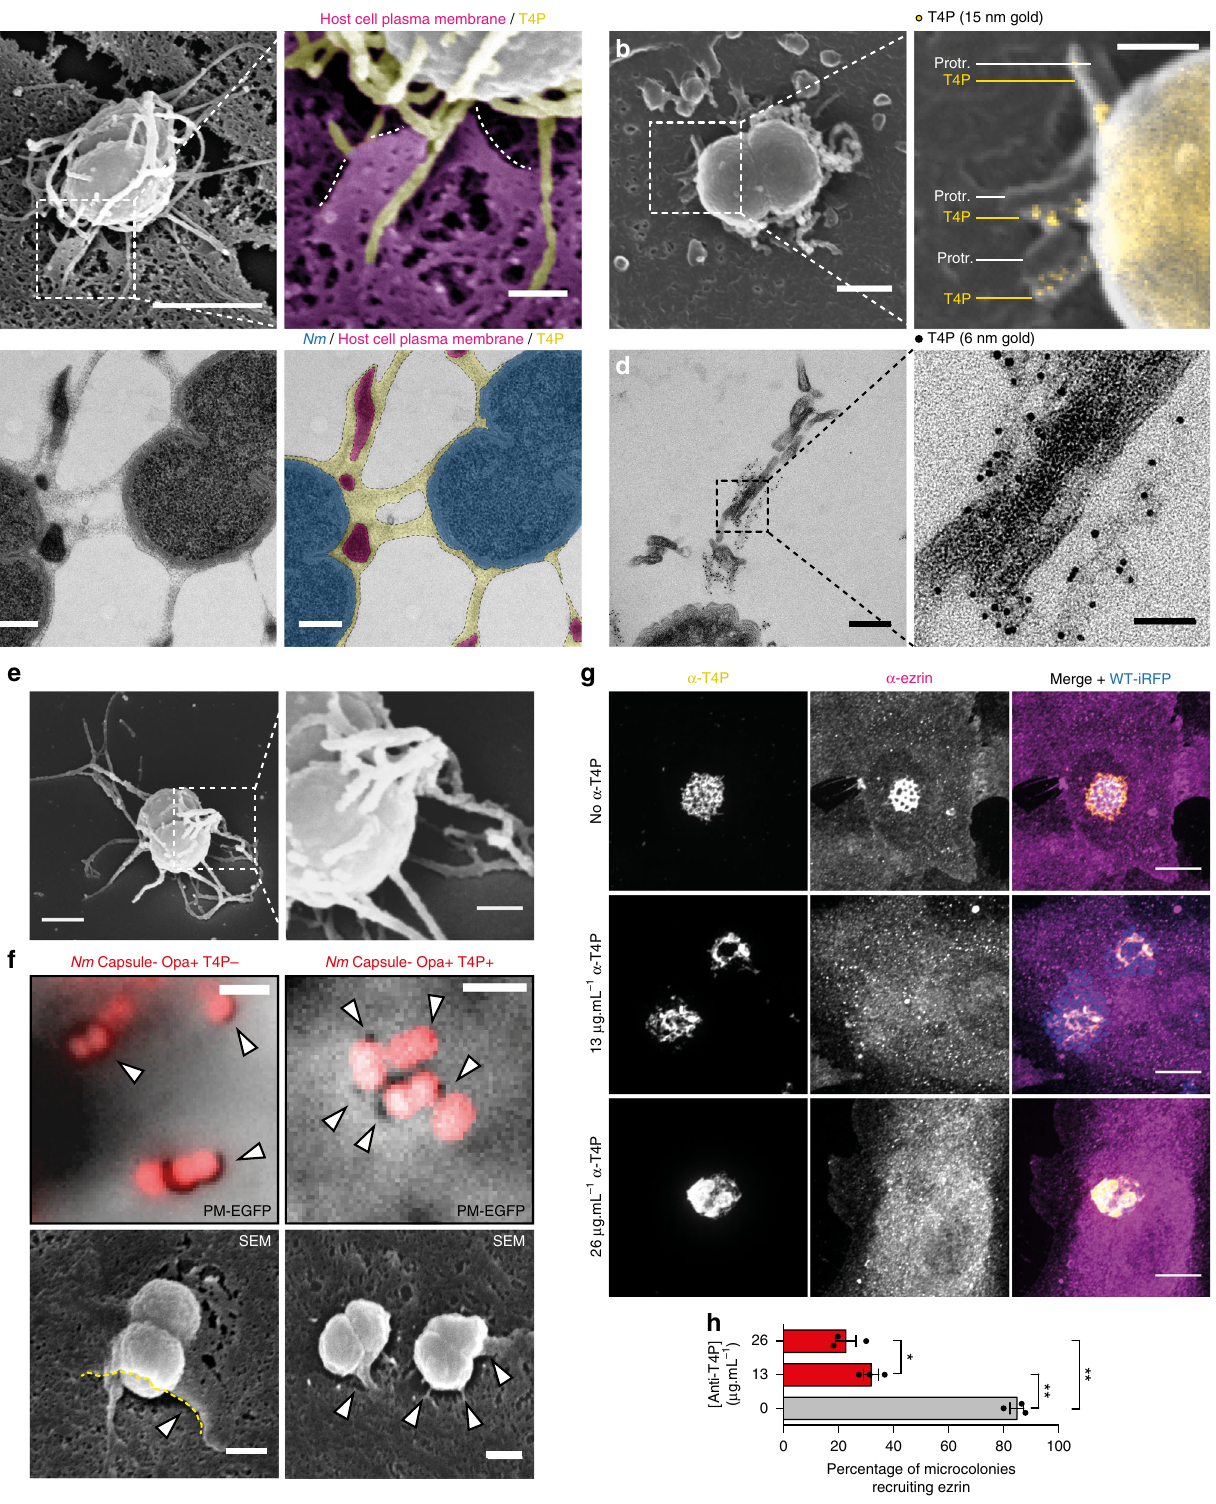
term is the retraction force acting on the tube while the second term is the driving force due to the adhesion along the fi ber. If f L > membrane curvature energy and the surface energy; W t = Γ l · U , 0, i.e. when the surface tension σ of the membrane is suf fi ciently where U is the ligand-receptor binding energy and Γ l is the low, a membrane nanotube can grow along the fi ber. To number of ligands on the fi ber per unit length. From the free summarize, our model predicts that, for a given adhesion energy energy F 1D , we derived the driving force acting on the membrane ffiffiffiffiffiffiffiffiffiffi p between receptors in the phospholipid bilayer and an ¼ (cid:2) 2 π σ þ W nanotube, f 2 κ (See Methods). Here, the fi rst L b t